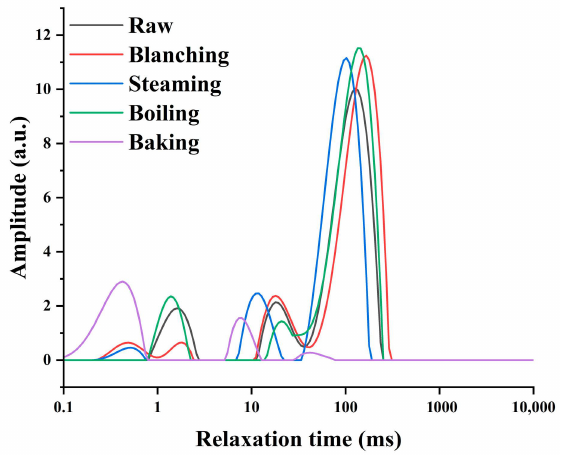
Figure 2. Distribution of T 2 relaxation times in L. japonica cooked with four different cooking